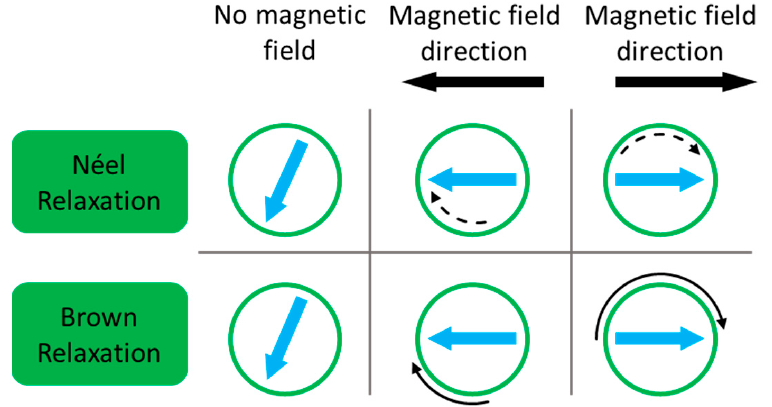
Figure 11. Mechanisms of heat generation in single domain superparamagnetic NPs upon exposure to an alternating magnetic field (AMF). Green circles represent NPs and blue arrows indicate the direction of the magnetic moment. In the case of single-domain MNPs, magnetic relaxation occurs in the form of internal changes in the magnetic moment direction (Néel, dashed black arrows) or physical movement (Brown, solid black arrows) as the particles attempt to align with the applied magnetic field. Adapted from Suriyanto et al. [151].